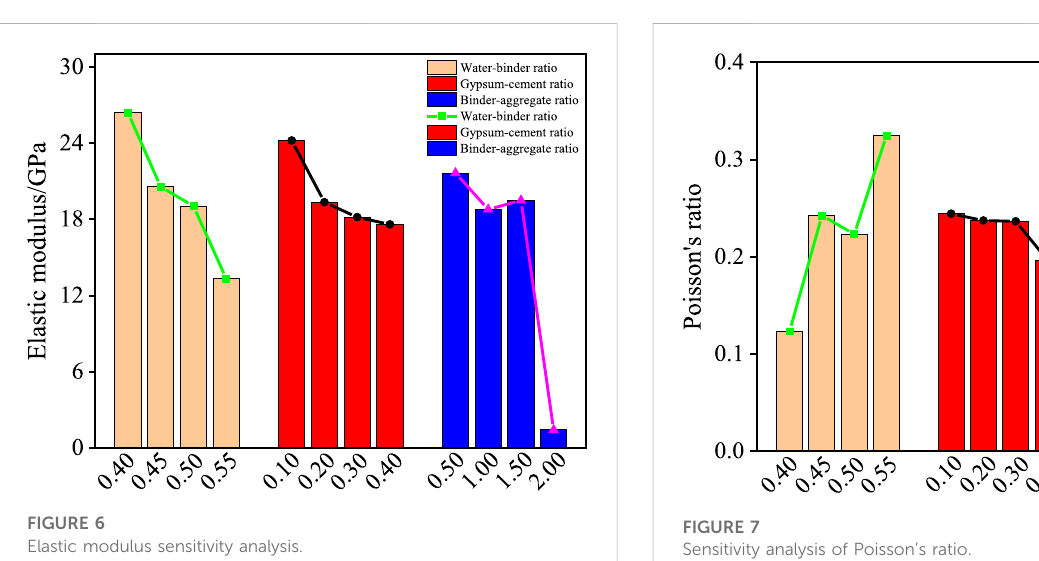
FIGURE 7 Sensitivity analysis of Poisson ’ s